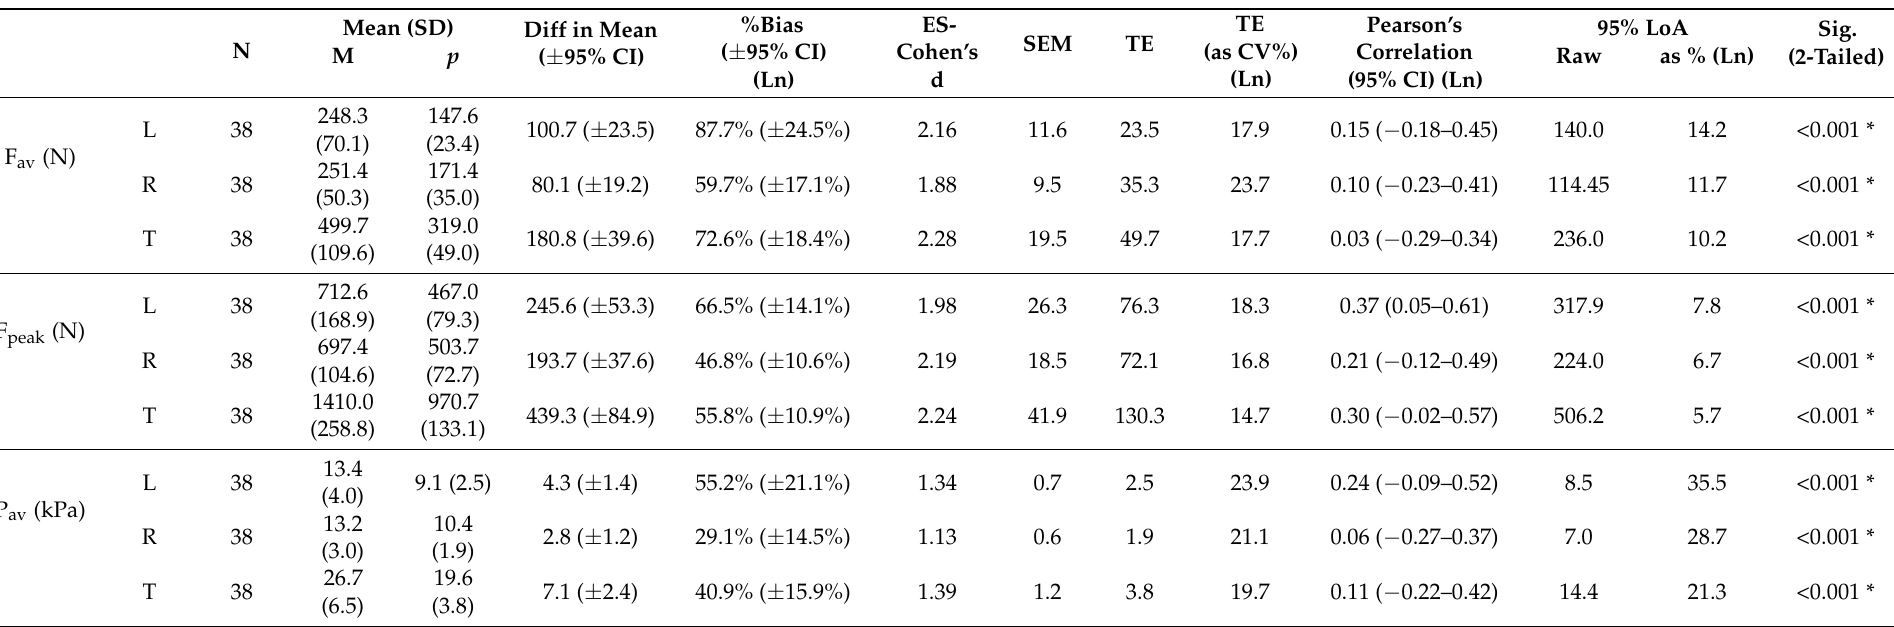
Table 2. Validity and agreement plantar pressure and reaction variables between Moticon insoles (practical) and Pedar-x